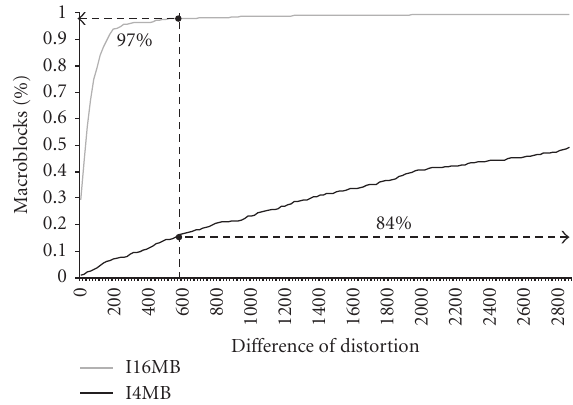
Figure 6: Percentage of modes chosen by the RDO technique and di ff erence of distortion (DD) for the